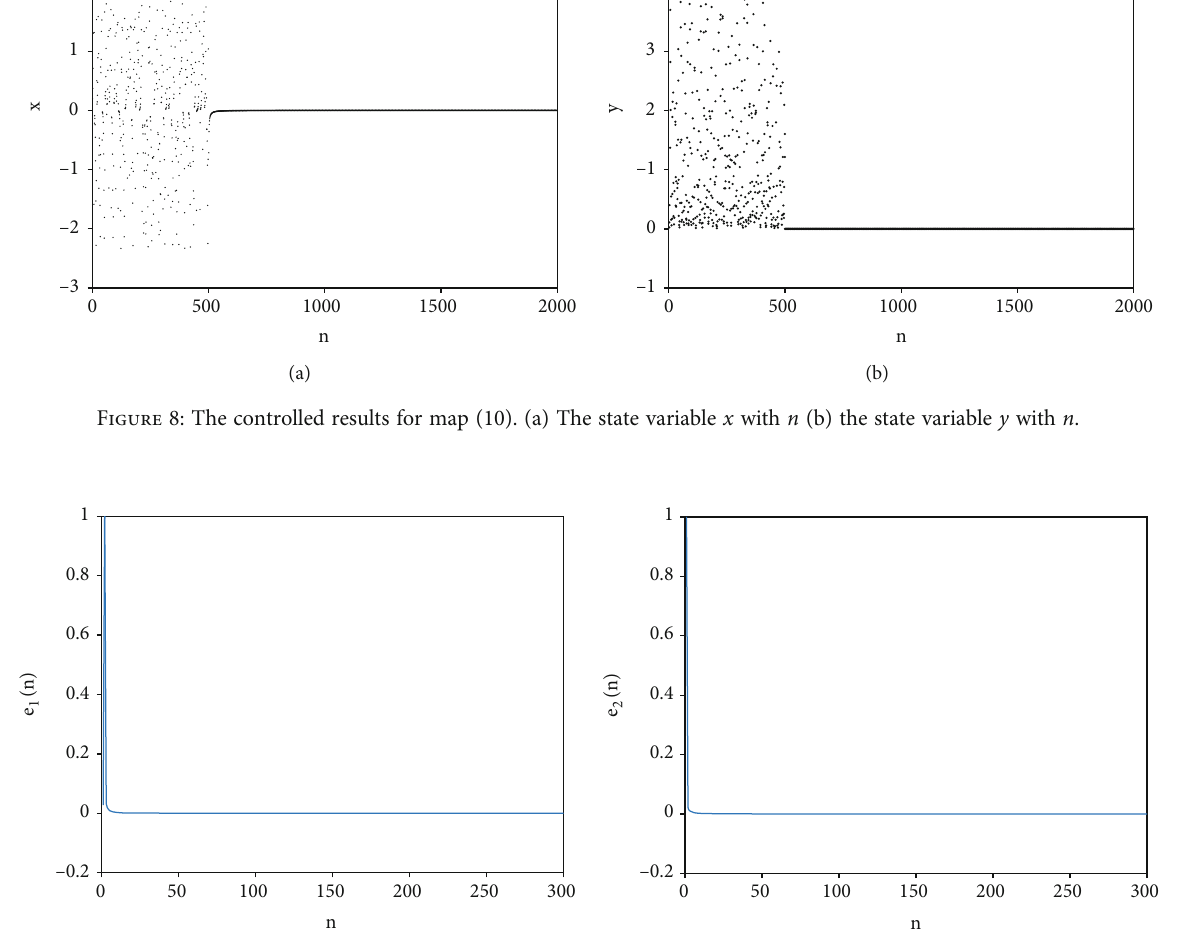
ð n Þ with n . (b) e 1